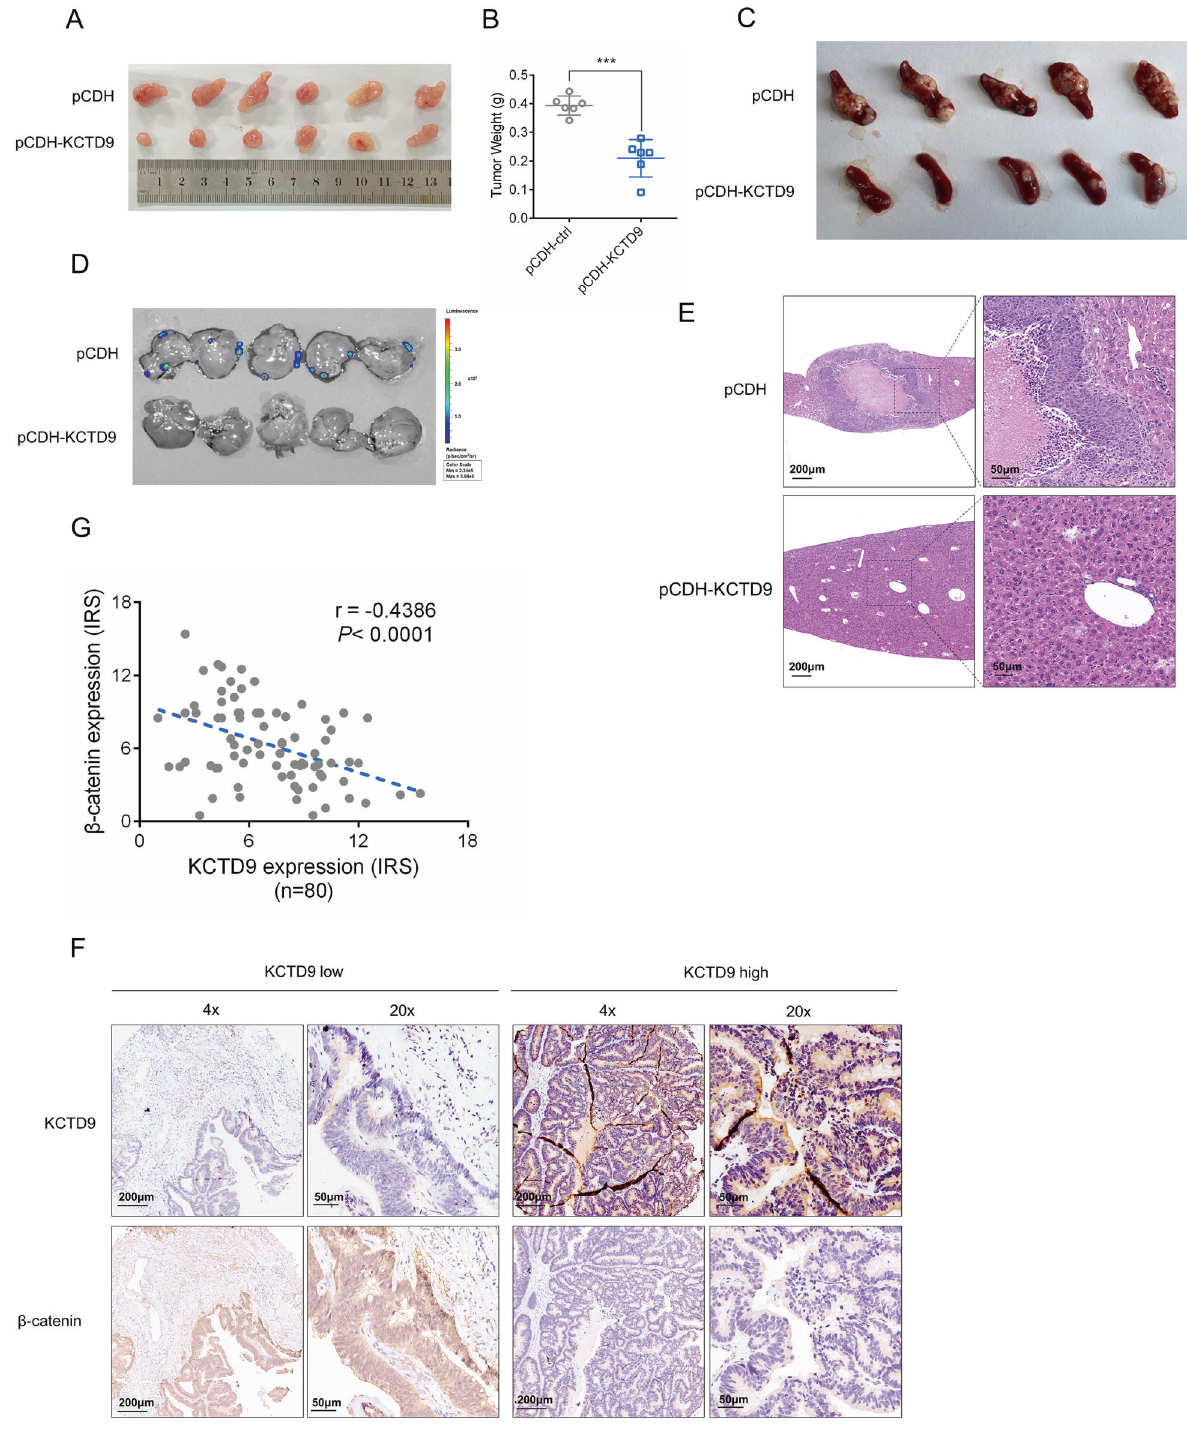
Fig. 7 KCTD9 inhibits CRC growth and metastasis in vivo. A , B SW620 cells without (pCDH) or with overexpression KCTD9 (pCDH-KCTD9) were subcutaneously inoculated into nude mice. Images ( A ) and weights ( B ) of the excised xenografts recovered at 21 days. Data represent mean ± SD, n = 6 mice per group, two-tailed Student ’ s t test, *** p < 0.001. C – E SW620 cells without (pCDH) or with overexpression KCTD9 (pCDH-KCTD9) were inoculated under the spleen capsule of nude mice to measure spleen to liver metastasis using a luciferase-based bioluminescence assay. Images of the excised spleens recovered at 28 days ( C ) along with bioluminescence images of whole livers ( D ) and hematoxylin and eosin ( E ) stained sections of liver tissue. n = 5 mice per group. F , G Tissue microarrays containing 80 human CRC tissues were analyzed in parallel for expression of KCTD9 and β -catenin using immunohistochemical (IHC) staining. Representative staining of cases with low and high expression of KCTD9, respectively ( F ) and quanti fi cation of IHC staining as immunoreactive scores (IRS) ( G ). The Pearson correlation coef fi cient (r) was calculated as shown. ( n = 80).